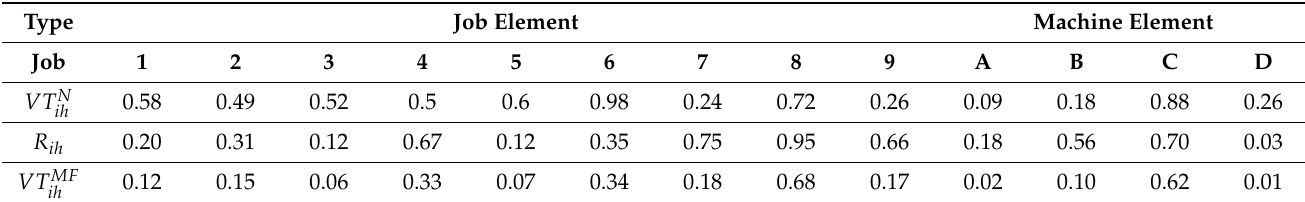
Table 6. Example values of the MF